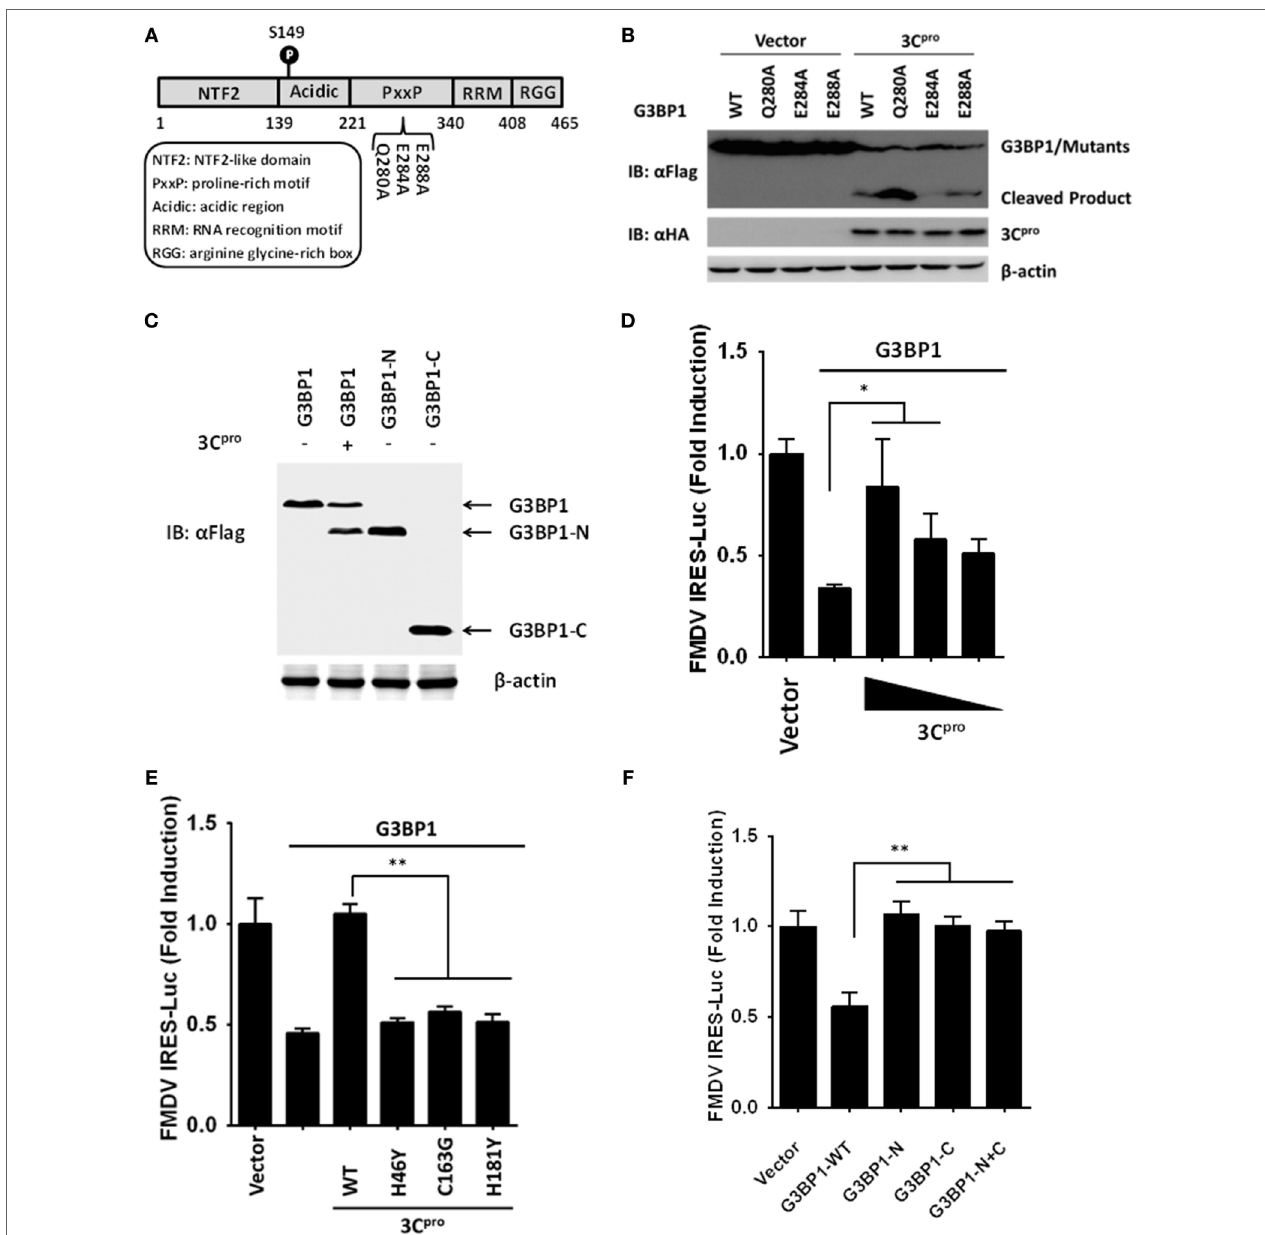
FigUre 7 | Foot-and-mouth disease virus 3C pro cleaves G3BP1 at E284 and inactivates G3BP1-mediated inhibition of internal ribosome entry site (IRES) activity. (a) Schematic representation of wild-type porcine G3BP1 and its derivatives. (B,c) Human embryonic kidney cells-293T cells cultured in 60-mm dishes were transfected with Flag-tagged wild-type porcine G3BP1 or its mutants as indicated, along with HA-3C pro or empty vector. Cell lysates were prepared 30 h post- transfection and analyzed by western blotting. (D) IBRS-2 cells were transfected with TK-Renilla luciferase(Rluc)-IRES-Firefly luciferase(Fluc) (0.05 µg), and Flag-tagged porcine G3BP1 expression plasmid (0.3 µg), along with increasing quantities of the plasmid encoding 3C pro (0.025, 0.05, and 0.1 µg). Luciferase assays were performed at 36 h after the transfection. (e) IBRS-2 cells were transfected with TK-Rluc-IRES-Fluc (0.05 µg), and Flag-tagged porcine G3BP1 expression plasmid (0.3 µg), along with the designated 3C pro expression plasmids (0.1 µg). Luciferase assays were performed at 36 h after the transfection. (F) IBRS-2 cells were cotransfected with TK-Rluc-IRES-Fluc, and either a plasmid encoding Flag-fused wild-type porcine G3BP1, a plasmid encoding putative 3C pro -induced cleavage fragments of G3BP1, or an empty vector (0.4 µg). Luciferase assays were performed at 36 h after the